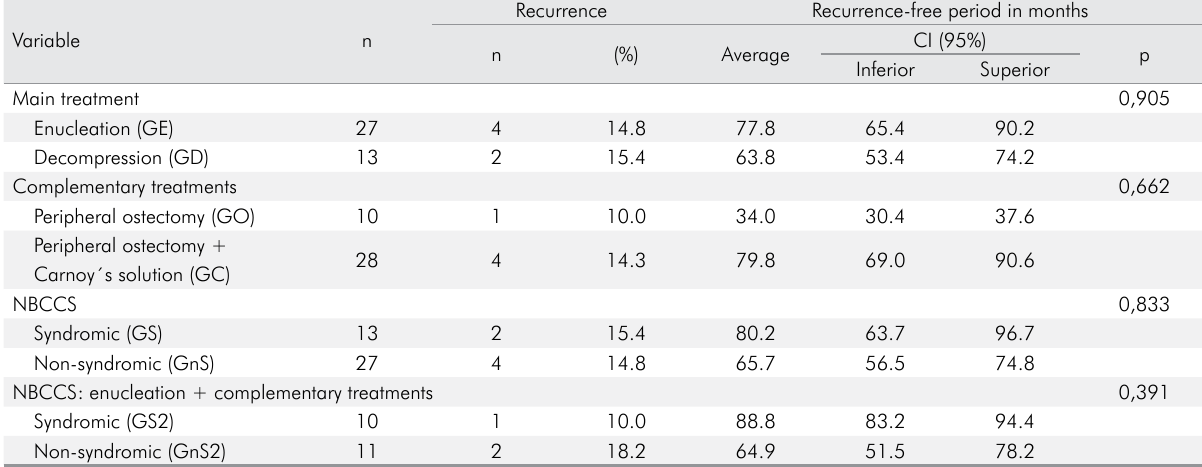
Table 1. The recurrence (%) and estimation of the recurrence-free period by the Kaplan-Meier function is summarized with a p-value reported for the comparisons between